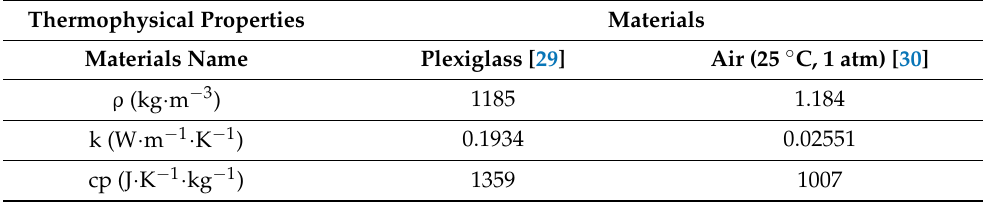
Table 9. Properties of